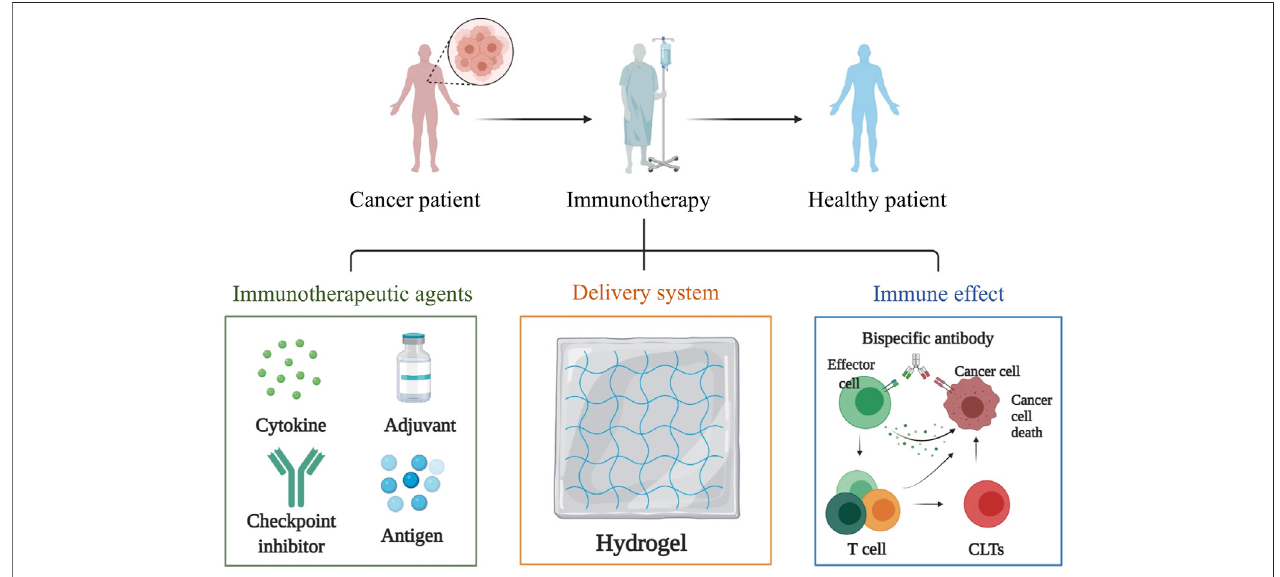
FIGURE 3 | Hydrogels applied in the delivery of immunomodulatory molecules which include cytokine, adjuvant, checkpoint inhibitor and antigen. These immunomodulatory molecules can be loaded to the biocompatible hydrogel in a simple and gentle way to ensure the biological activity of these immunomodulatory factors, enabling them to exert their immune